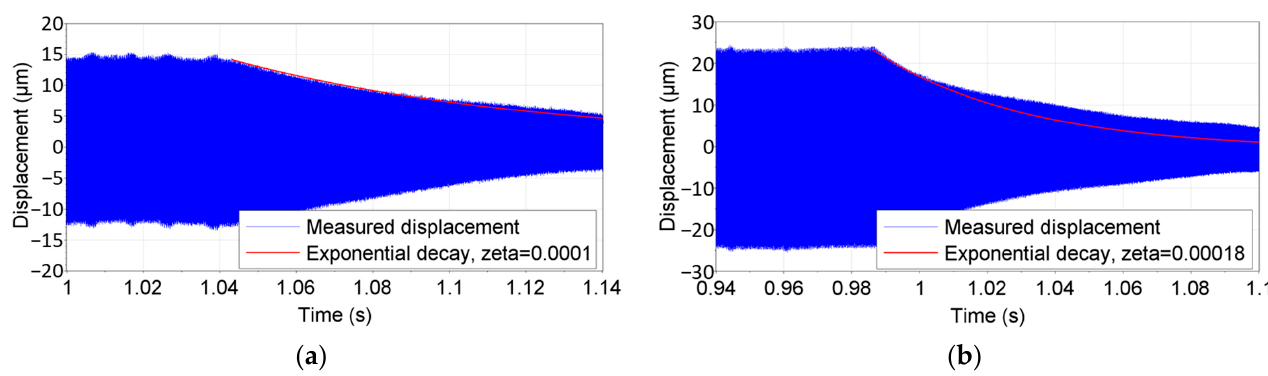
Figure 15. Inconel 625, UHCF specimen, exponential decay: ( a ) Maximum stress = 200 MPa; ( b ) Maximum stress = 356 MPa.